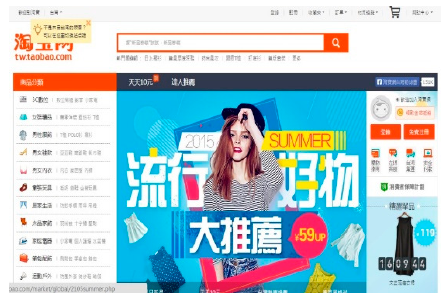
Figure 2. Taobao home page.